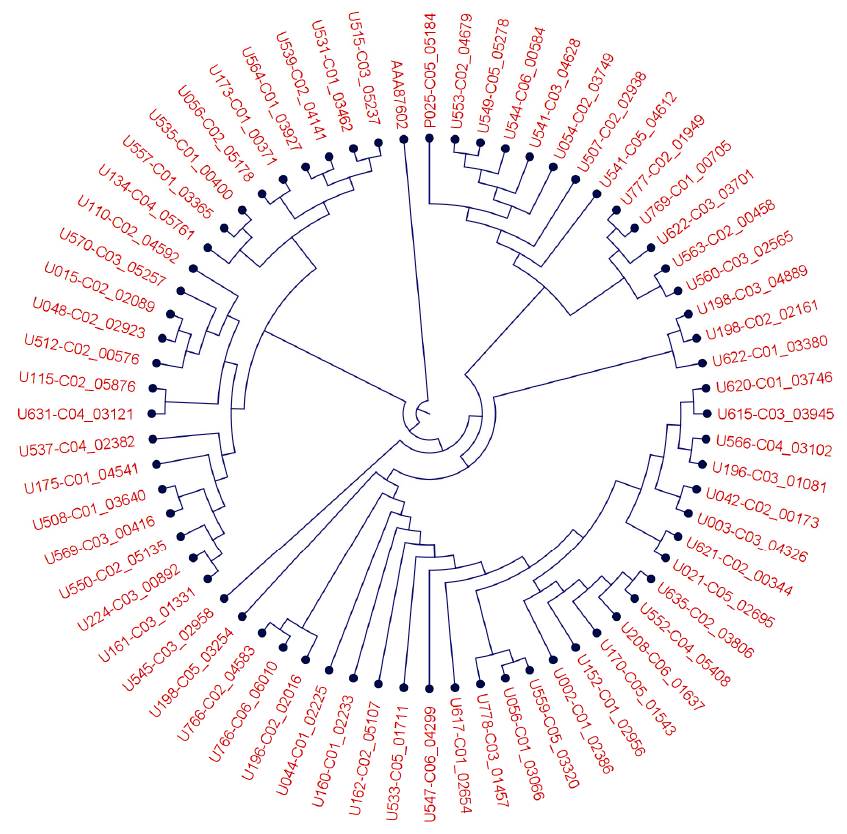
Figure 3. Phylogenetic tree of B. megaterium CYP450BM3 like proteins and the B. megaterium BM3 protein (AAA87602.1) demonstrating a protein sequence diversity across different strains. Root was set above AAA87602.1.